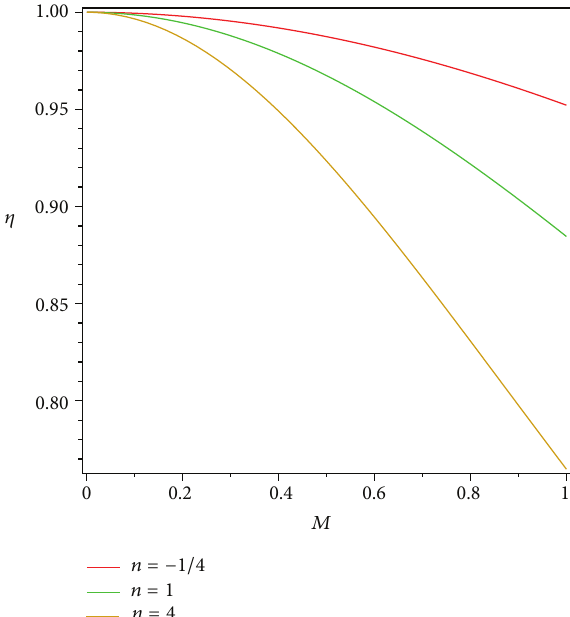
Figure 7: Fin efficiency for the profile 𝑓(𝑥) = (𝑥 + 1) 3 as given in solution (25) in a fin with varying values of 𝑛